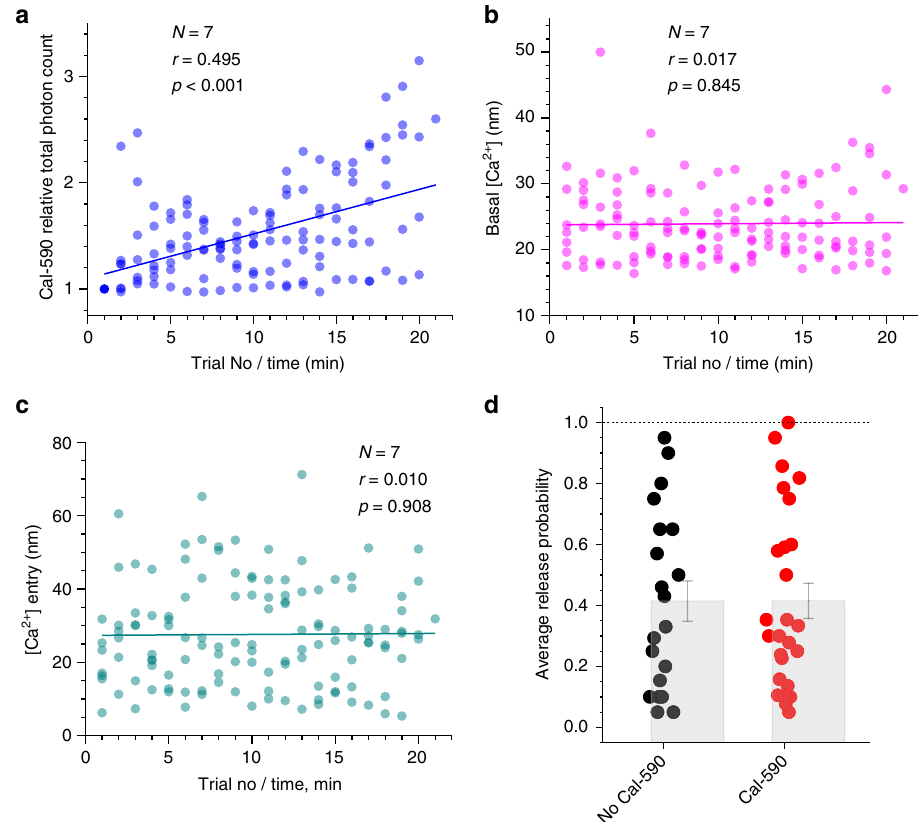
Fig. 4 Intra-axonal Ca 2 + buffering by Cal-590 has little effect on [Ca 2 + ] fl uorescence lifetime imaging microscopic (FLIM) readout or average release probability. a Total photon count for Cal-590 ( fl uorescence intensity, measured within 300 ms before the evoked four-action potential (four-AP) train at 20 Hz, as in Figs. 3 and 4), normalised to the initial value, as recorded in individual axonal boutons ( N = 7), plotted against the trial number (time). In these experiments, the intra-axonal Cal-590 concentration, hence Ca 2 + buffering capacity, continues to rise with time, before eventual equilibration; solid line, linear regression ( r , Pearson correlation; p < 0.001, slope signi fi cance). b Presynaptic resting [Ca 2 + ] measured within 300 ms before the evoked four-AP train using Cal-590 FLIM readout, at axonal boutons shown in a , plotted against the trial number (time); other notation as in a (no correlation). c An increment in presynaptic [Ca 2 + ] during evoked four-AP train measured with Cal-590 FLIM, at axonal boutons shown in a , b , plotted against the trial number (time); other notation as in a , b (no correlation). d Probability of evoked glutamate release (in response to a single action potential) in axonal boutons of CA3 pyramidal cells (organotypic hippocampal slices) expressing SF-iGluSnFR, with and without Cal-590 (300 µ M) being loaded and equilibrated in whole-cell mode, as indicated. Dots, individual bouton recordings; bar graph, mean ± s.e.m. (0.41 ± 0.07 and 0.42± 0.06, n = 20 and n = 26, without and with Cal-590,